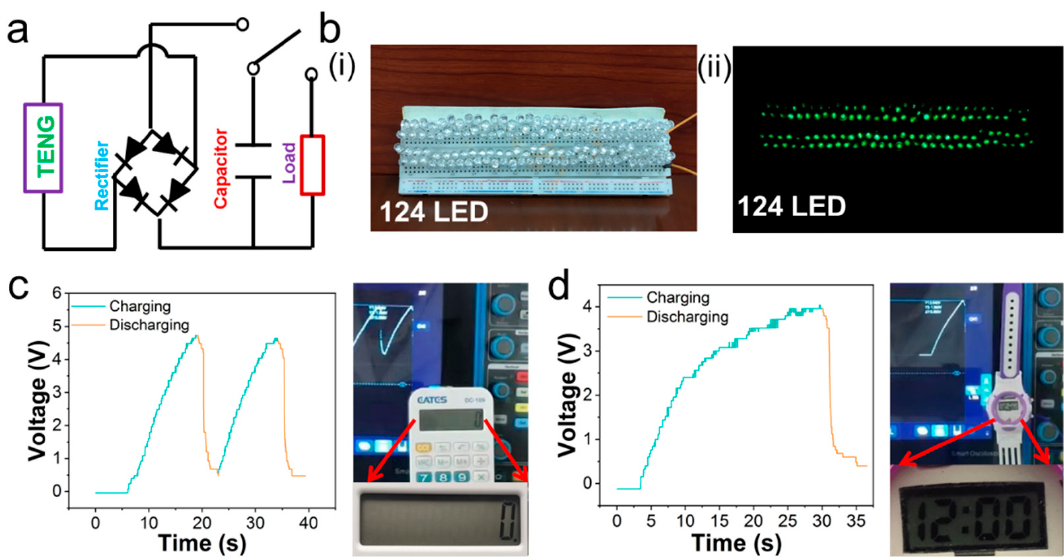
Figure 4. Power supply performance test of SD-TENG. ( a ) Equivalent circuit diagram of SD-TENG for charging and discharging. ( b ) The SD-TENG is used as a power supply to light up 124 green LEDs. ( c ) The SD-TENG charges a calculator. ( d ) The charging of an electronic watch.